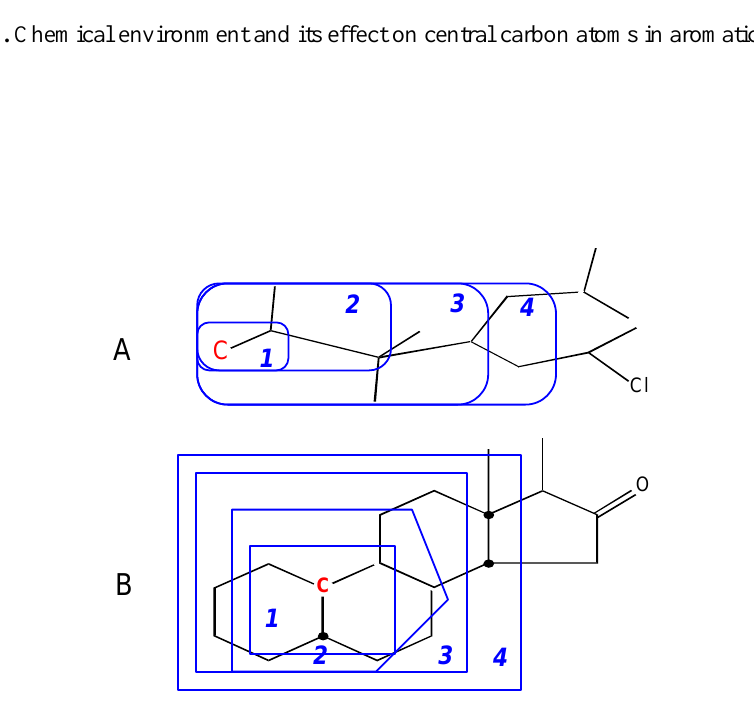
Figure 4. Atom layers in different systems. A: Layer 4 is too far for this center atom (in red color). B: Layer 4 is still not far enough for this center atom (in red color). The numbers represent atom layers.